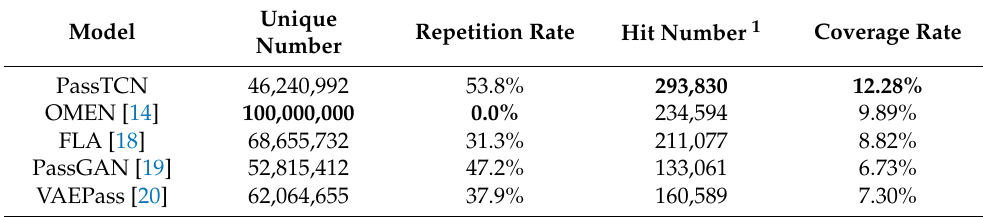
Table 4. The repetition rate and the coverage rate of PassTCN model compared with other models when 10 8 passwords are